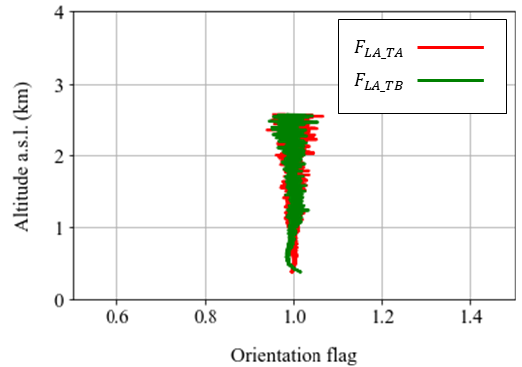
Figure 14. Average values of the orientation flags F LA_TA (red) and F LA_TB (green), for the measurements shown in Fig. 13, acquired in Athens, Greece, on 15 June 2021, at 14:33–15:02UTC. The aver- ages are performed for the cloud-free profiles shown in Fig. 13, with duration of 22min, and they are plotted from the overlap height up to the top of the aerosol layer, at